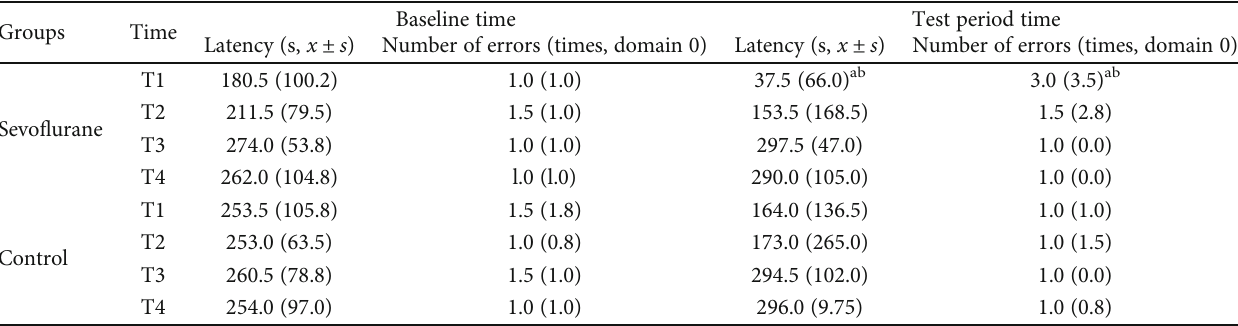
Table 3: E ff ect of sevo fl urane on latency and error times in the step-down latency test of mice ( n = 10 ).